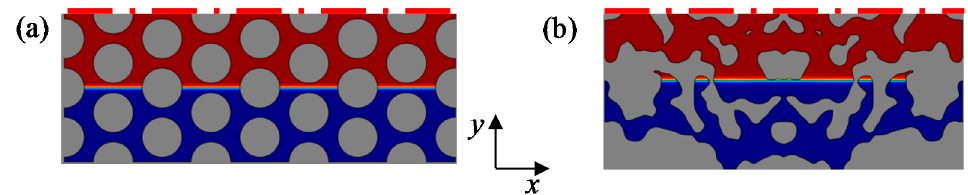
Figure 4. Example of initial oil (red) and water (blue) phase distribution pattern within ( a ) HDa and ( b ) E4 for S o = 0.5. Horizontal dashed-dotted lines indicate axes of symmetry of the systems. μ μ The simulations are performed by considering w = 0.001 Pa s and o = 0.002 Pa s (i.e., a σ μ μ viscosity ratio o w = 2), water and oil density equal to 1000 kg m − 3 , and interfacial tension = 0.04 N m − 1 , these values being representative of a typical oil/water system at reservoir condition